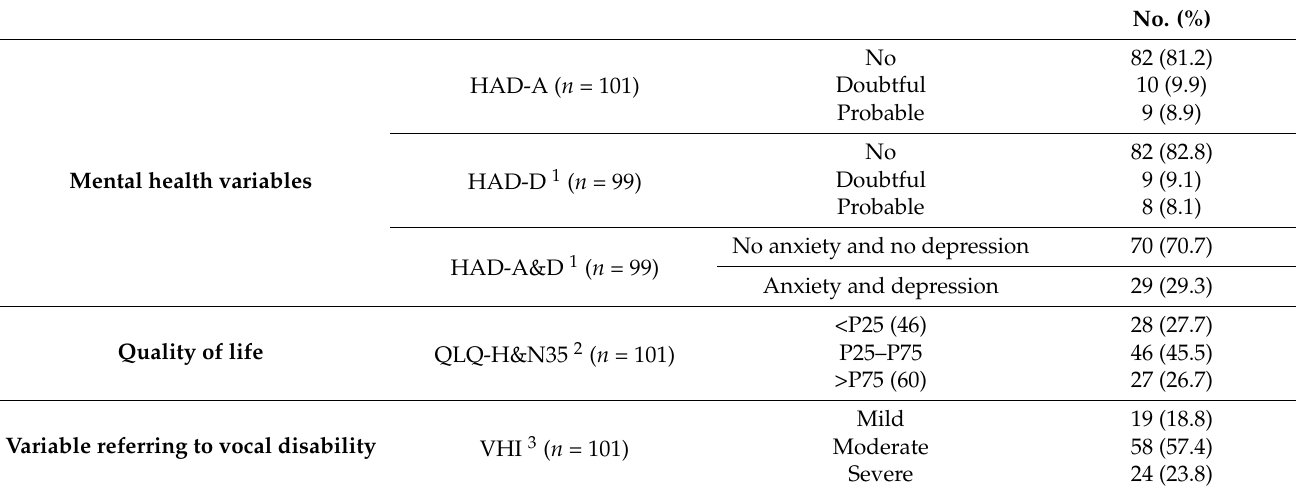
Table 2. Mental health, quality of life and vocal disability.